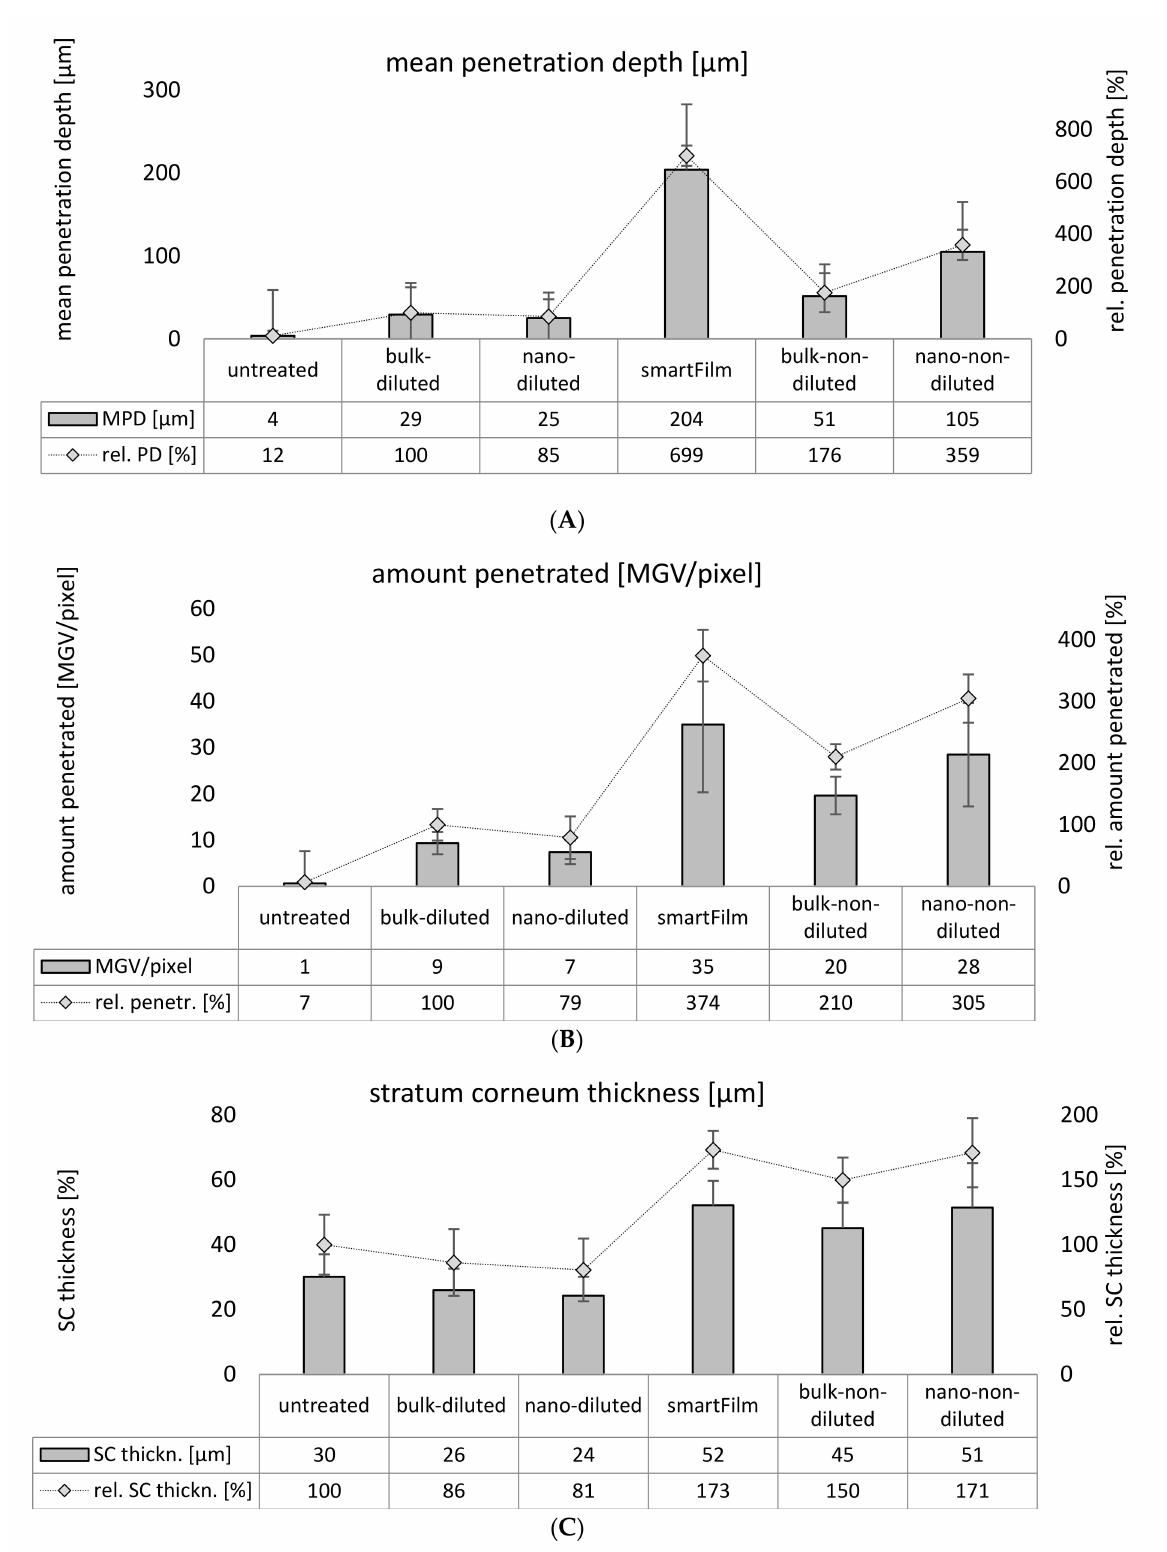
Figure 6. Dermal penetration efficacy of curcumin from smartFilms and benchmark controls: ( A )—mean penetration depth, ( B )—total amount of penetrated curcumin, expressed as mean gray value (MGV/pixel), ( C )—thickness of stratum